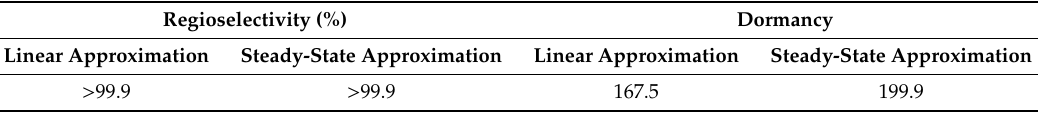
Table 3. Estimation of the regioselectivity of propylene insertion and dormancy of a regiodefected site a. Regioselectivity